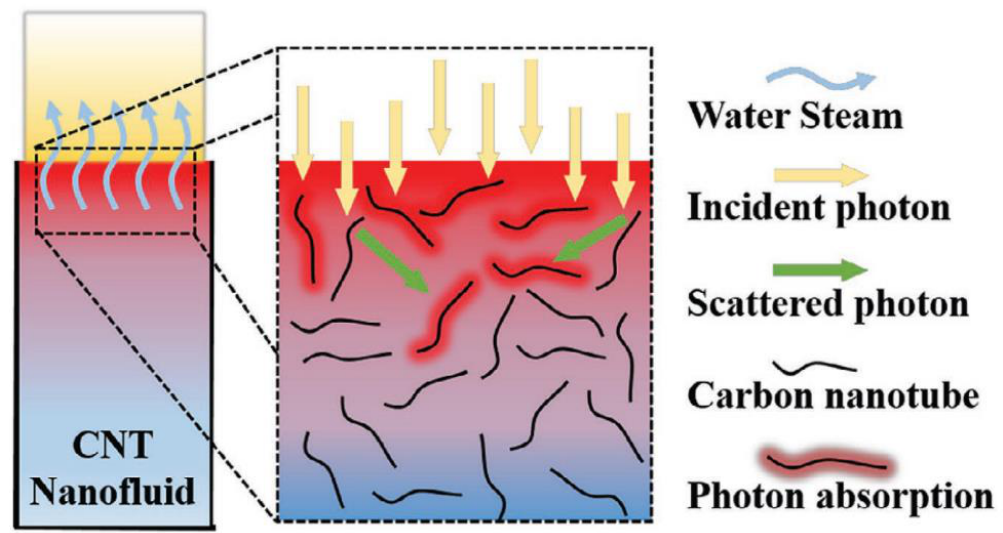
Energies 2020 , 13 , x FOR PEER REVIEW Figure 23. Schematic of the localized solar heating and steam generation mechanism [93]; 2018, Wiley.